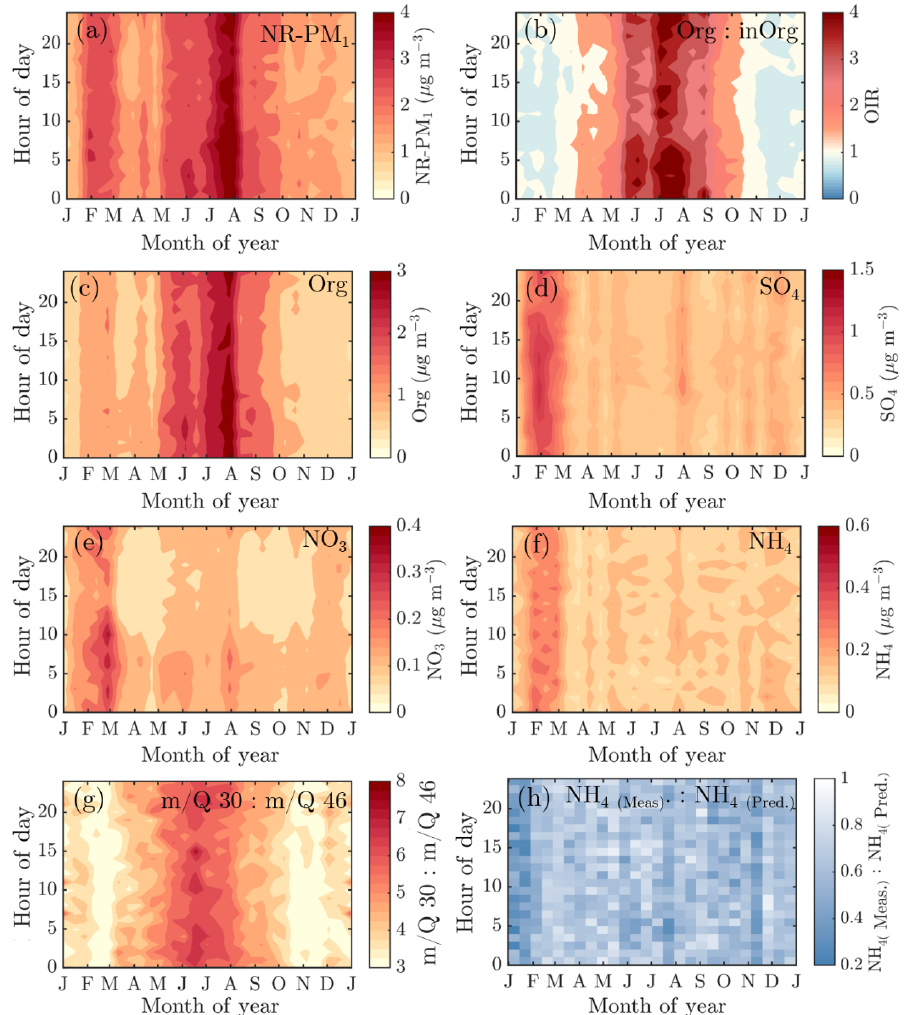
Figure 7. The median diurnal cycles of NR-PM 1 (a) , organic to inorganic ratio (b) , organic aerosol (c) , sulfate (d) , nitrate (e) , ammonium (f) , m/Q 30: m/Q 46 Th fragmentation ratio (g) , and the ratio between measured and predicted ammonium (h) . The y axes represent the local time of day (UTC + 2), and the x axes represent the month. The color scales present the mass concentration (a, c–f) or ratios (b, g–h) . Note that the scaling of the color bar is different in all of the figures. Panels (a) – (g) include interpolation of the 14d × 1h resolution data grid based on the MATLAB 2017a contourf function. Panel (h) has no interpolation involved due to the high noise level of the variable. The plot is produced with MATLAB 2017a pcolor